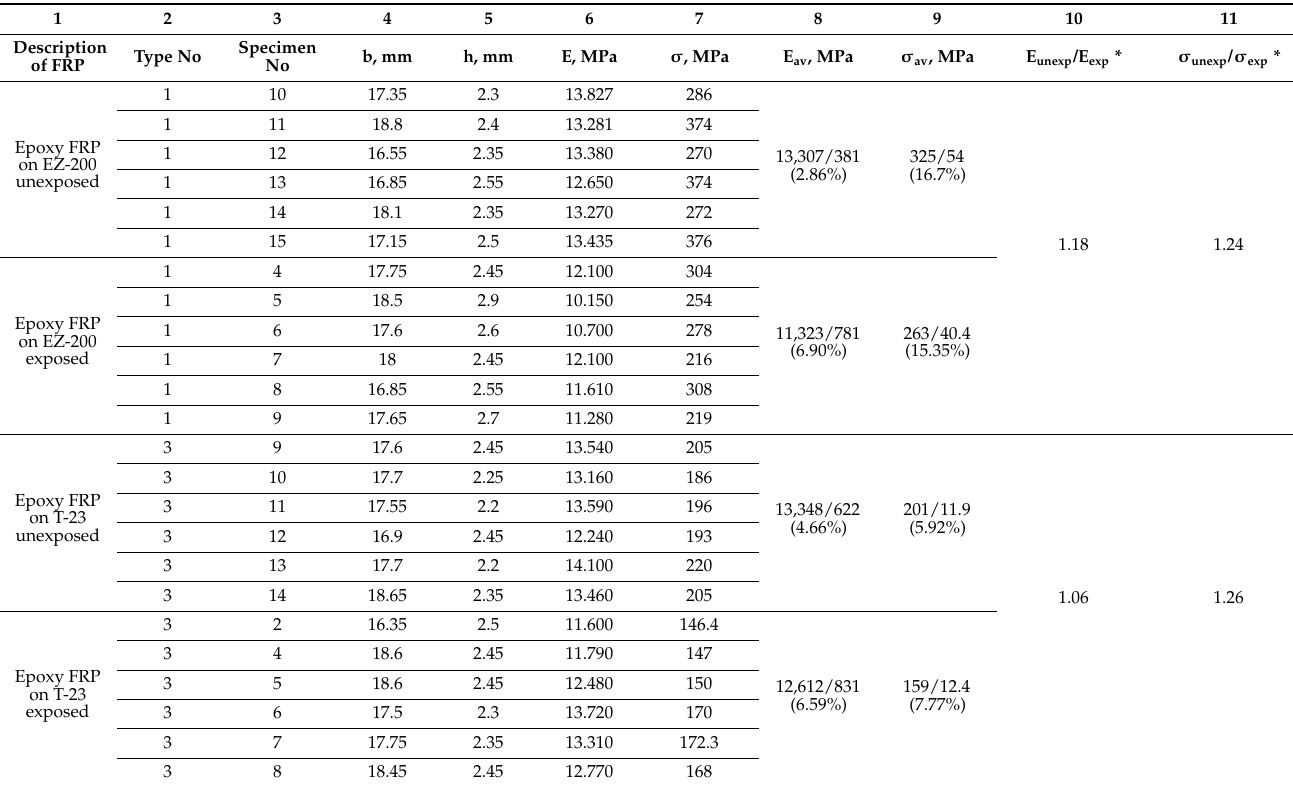
Table 1. Results of bending strength and modulus of elasticity at room temperature of fiberglass plastics before and after curing.